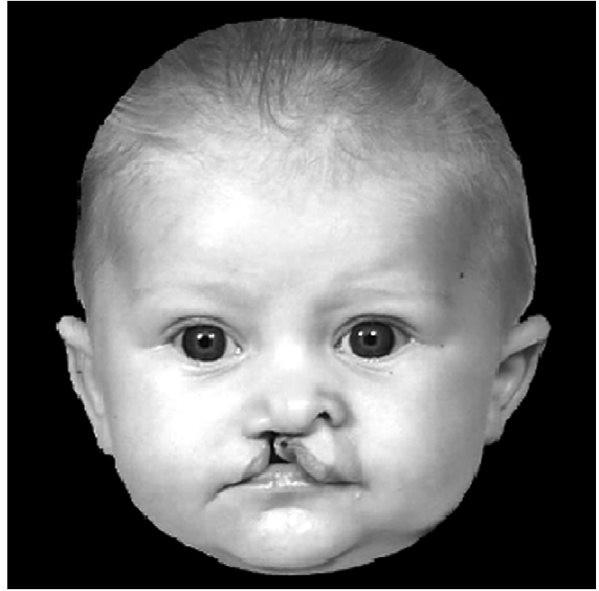
Figure 1. Example of an image of an infant with cleft lip.